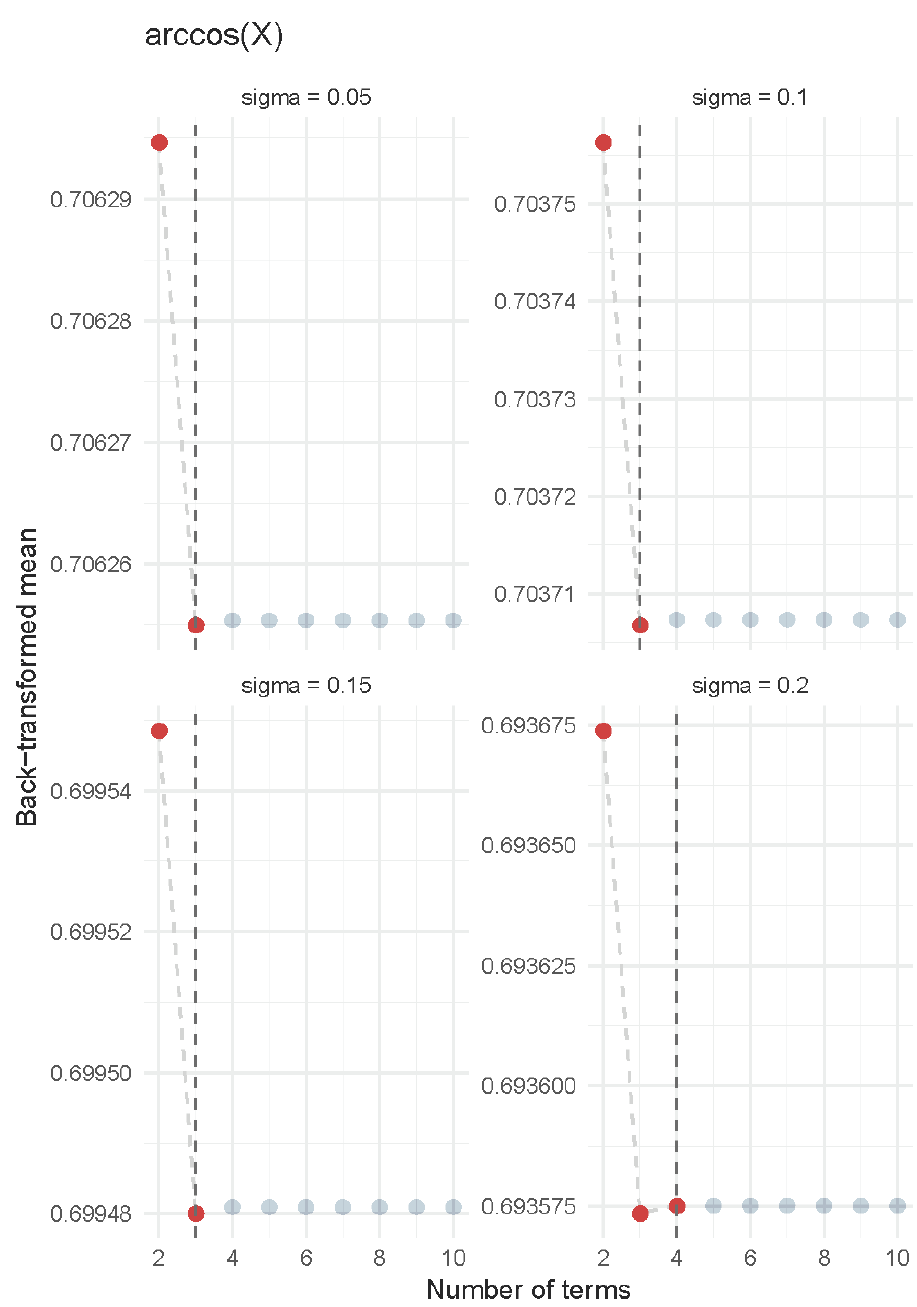
Figure 5. Convergence of the arccosine transformation according to the number of terms in the Taylor series expansion. The vertical dotted line identifies the number of terms for which two consecutive di ff erences between Taylor series estimates are less than the preset value of the order of 10 − 5 .